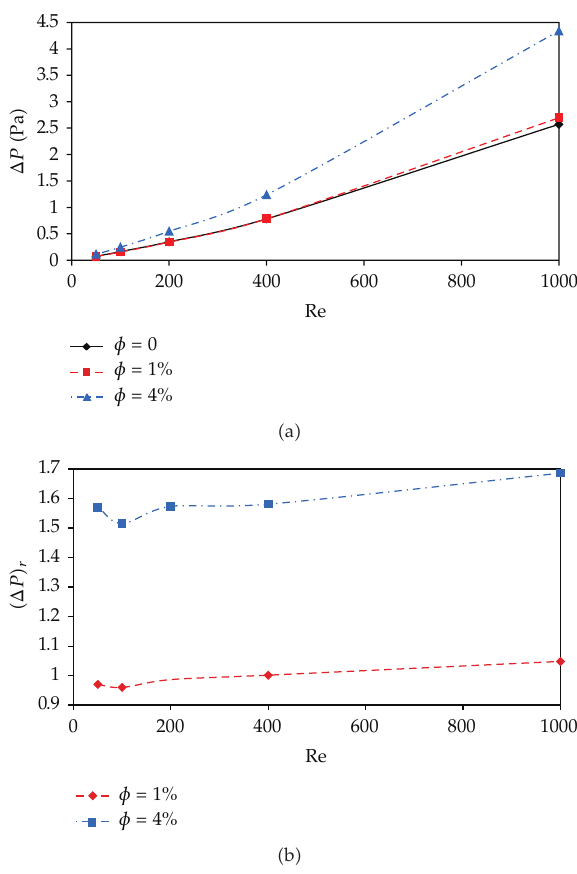
Figure 11: E ff ect of parameters φ and Re on: (cid:3) a (cid:5) pressure drop and (cid:3) b (cid:5) pressure drop